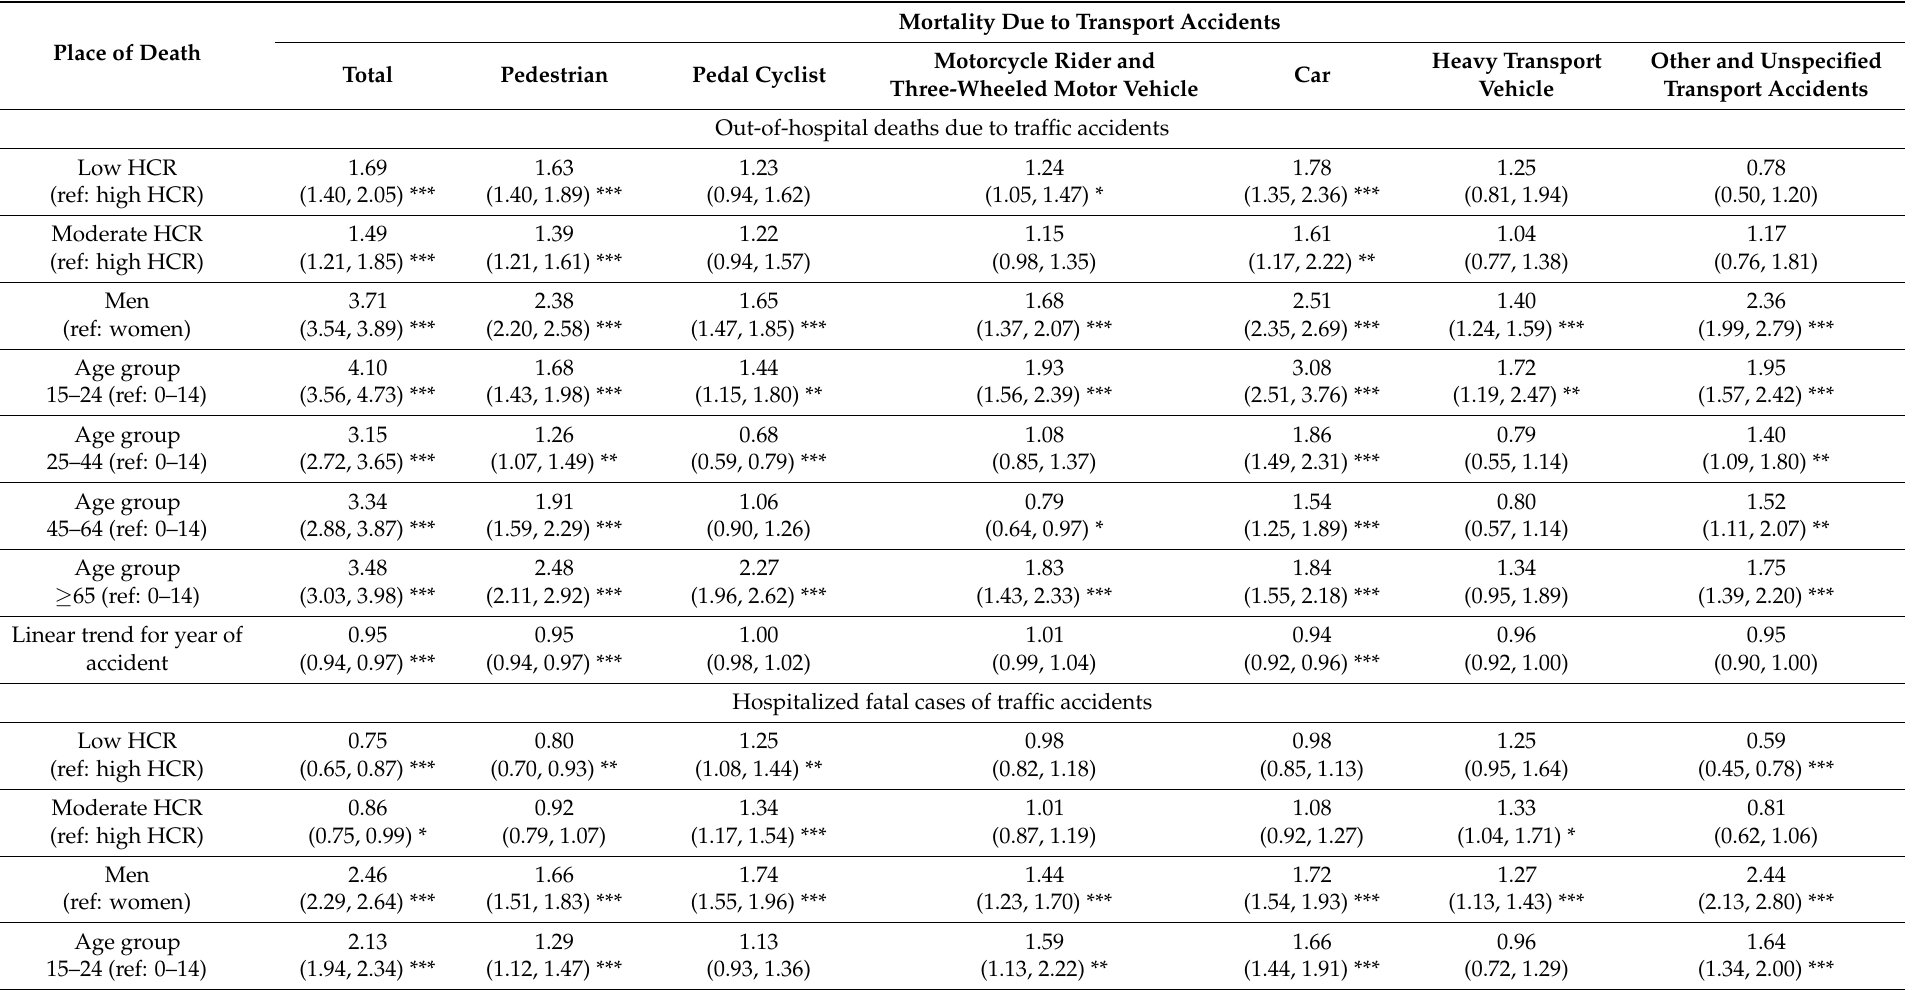
Table 3. Incidence rate ratio (IRR) for deaths due to transport accidents by health care resources (HCR), gender, age and temporal trend for out-of-hospital deaths, fatal hospitalized cases and for total deaths from accidents. Total Pedestrian Pedal Cyclist